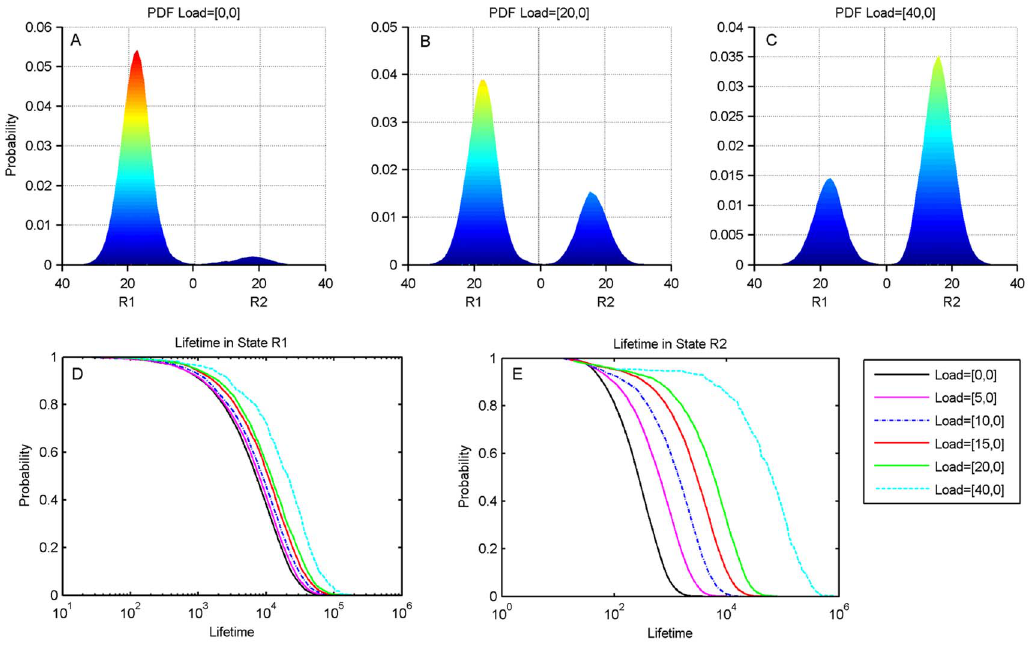
Figure 8. The genetic toggle switch with a positive feedback motif on Repressor 1 (R1). (A). The probability distribution function (pdf) with no load. The positive feedback on Repressor 1 leads to a pdf skewed in favor of R1. (B). The pdf with a load of 20 molecules on R1 showing the increase in the weight of R2 due to the ‘‘opposite side effect’’. (C). The pdf with a load of 40 molecules on R1. This load is more than enough to skew the pdf in favor of state R2. (D). Histogram of lifetimes in R1 with varying levels of load on R1. Comparison with panel A shows that the unloaded state has been stabilized by the positive feedback. Note that the lifetimes increase very slightly due to the ‘‘same side effect’’. (E). Histogram of lifetimes in R2 with varying levels of load on R1. The unloaded case is the curve on the extreme left. Note the initial asymmetry in the lifetime distribution due to the positive feedback, as well as the large increase in lifetimes with the inclusion of a load.